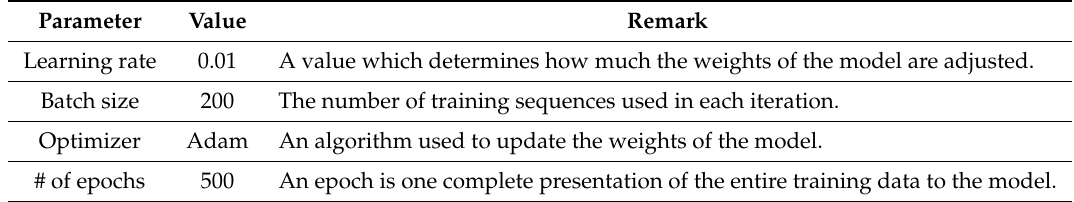
Table 1. Hyperparameters used for training the denoising autoencoder.